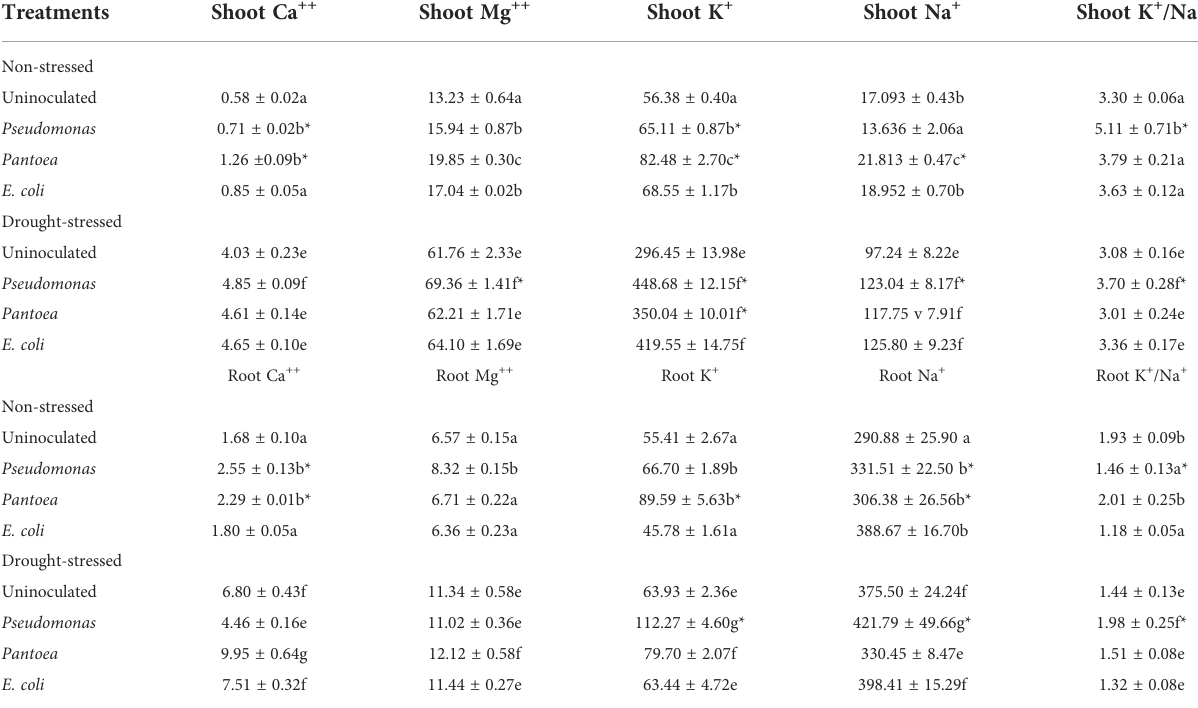
TABLE 3 Shoot and root cation (Ca ++ , Mg ++ , K + , Na + ) concentrations (mmol kg – 1 FW) and shoot K + /Na + ratio of drought-stressed and non- stressed (well-watered) Hordeum vulgare inoculated with three bacterial strains ( Pseudomonas sp. (ITS Group 11), Pantoea sp. (ITS Group 2), or E. coli ).